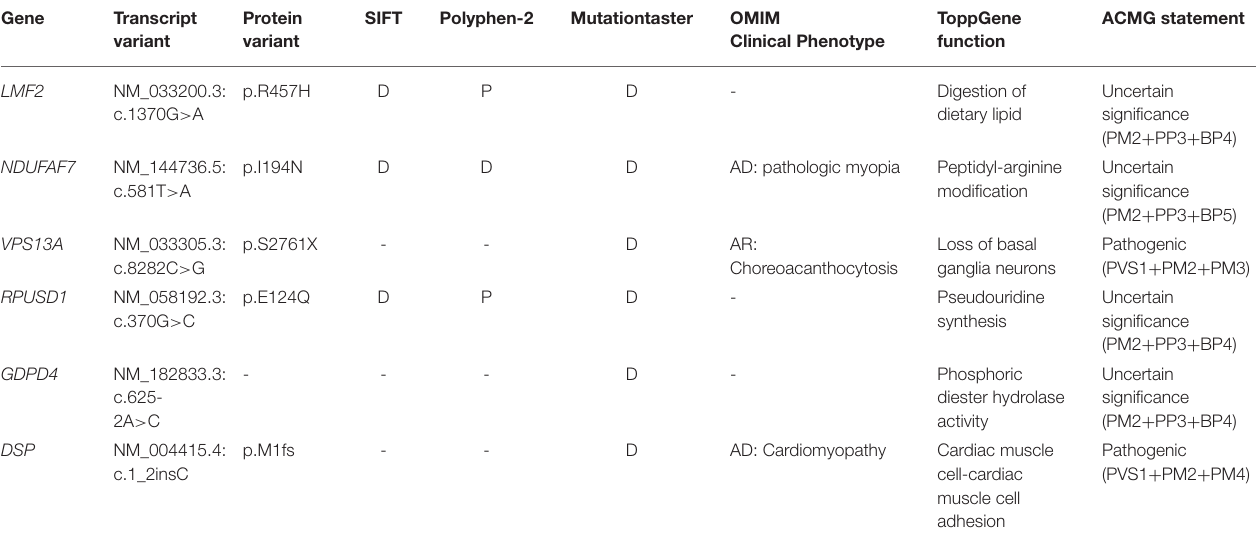
TABLE 2 | The filtered homozygous mutations of whole exome sequencing.